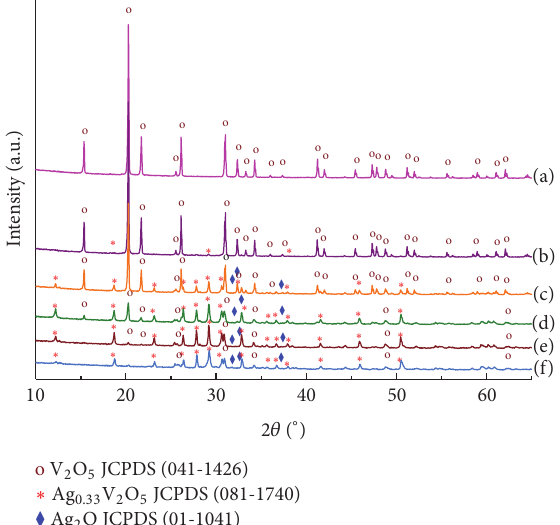
Figure 4: XRD diffraction patterns of (a) V 2 O 5 , (b) V 2 O 5 -1Ag, (c) V 2 O 5 -5Ag, (d) V 2 O 5 -10Ag, (e) V 2 O 5 -15Ag, and (f) V 2 O 5 -20Ag photocatalysts.